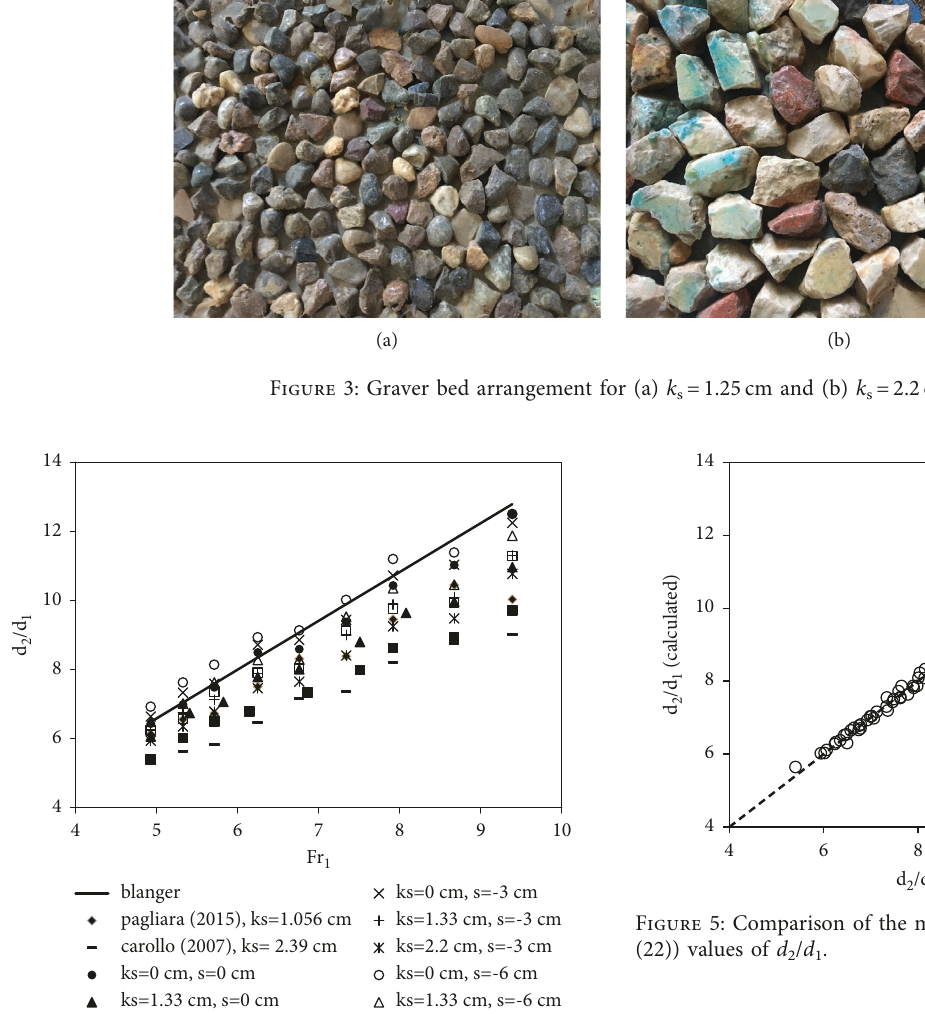
Figure 4: Variation of d 2 / d 1 with Fr 1 for different heights of roughness and negative steps.